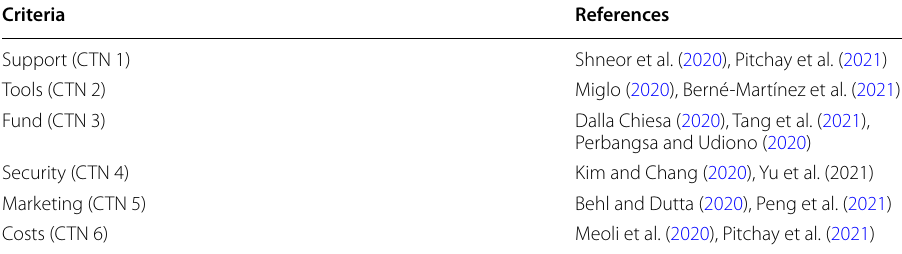
Table 1 Selection criteria of the crowdfunding platforms for smart grid project investors Criteria